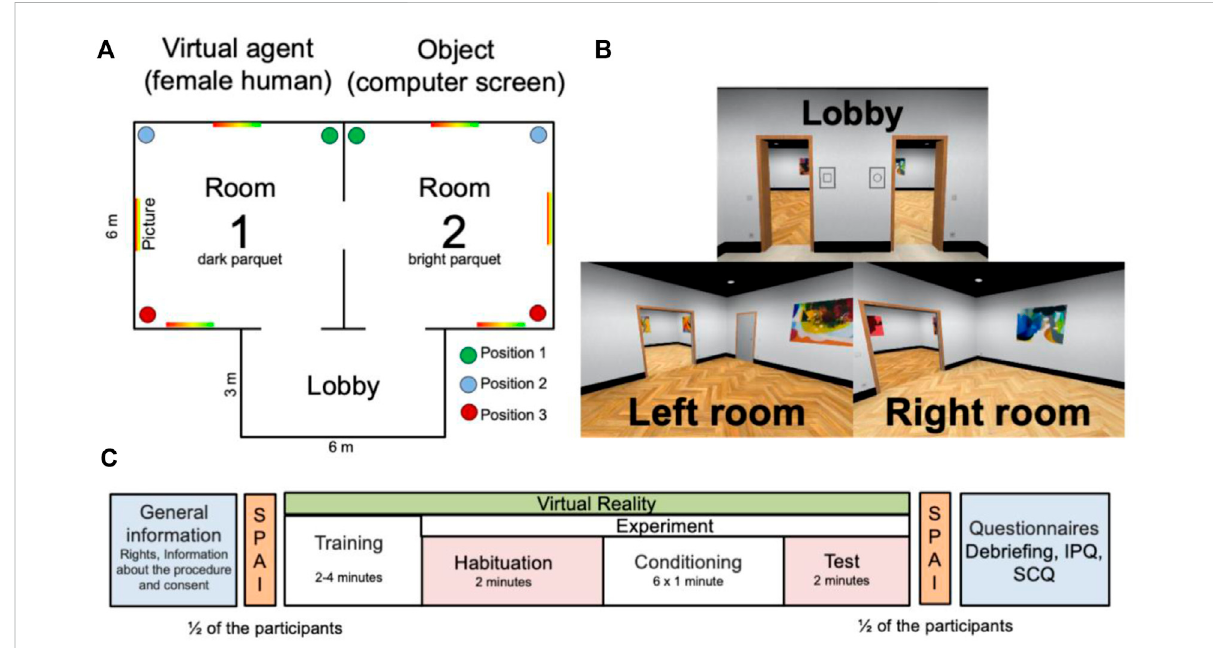
Schematicillustrationof the social conditioned place preference (SCPP) paradigm invirtual reality (VR)and theexperimental setup. (A) The two virtualmuseumroomsandthelobbyareconnectedthroughdoorsthatcanbevirtuallyclosed,allowingordenyingaccesstoindividualroomsduring the experiment. Positions 1 – 3 are the sequence of positions in which the agent and neutral object were placed during the conditioning phase. (B) Example screenshots ofthevirtual environments.During theexperiment, these werestereoscopically presented ina360 ° + fl oor. (C)